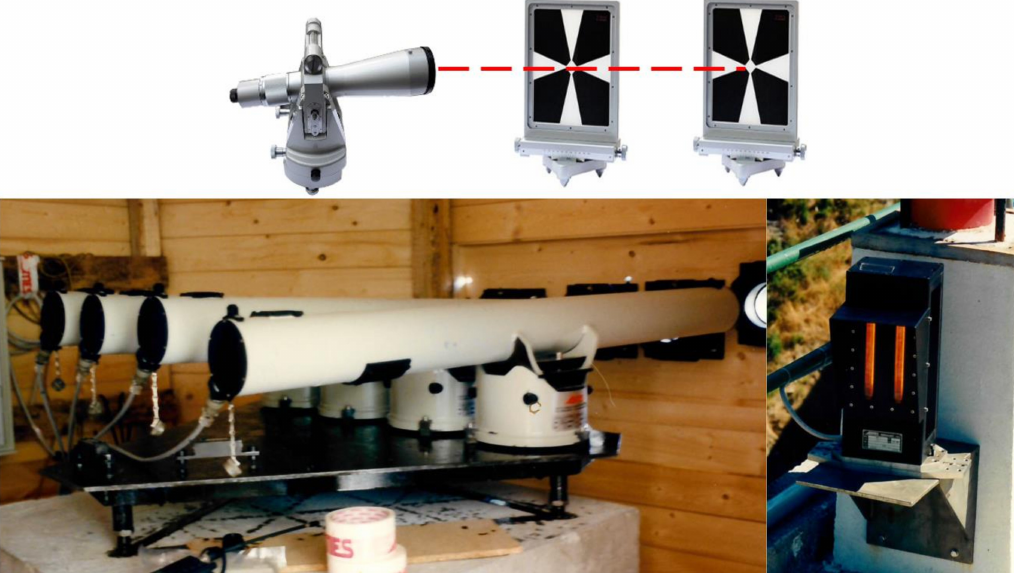
Figure 1. Evolution of collimators from purely manual instruments (on the top) to opto-electronic automatic systems (on the bottom: ISAC 5000 by ISMES S.p.a., Seriate,